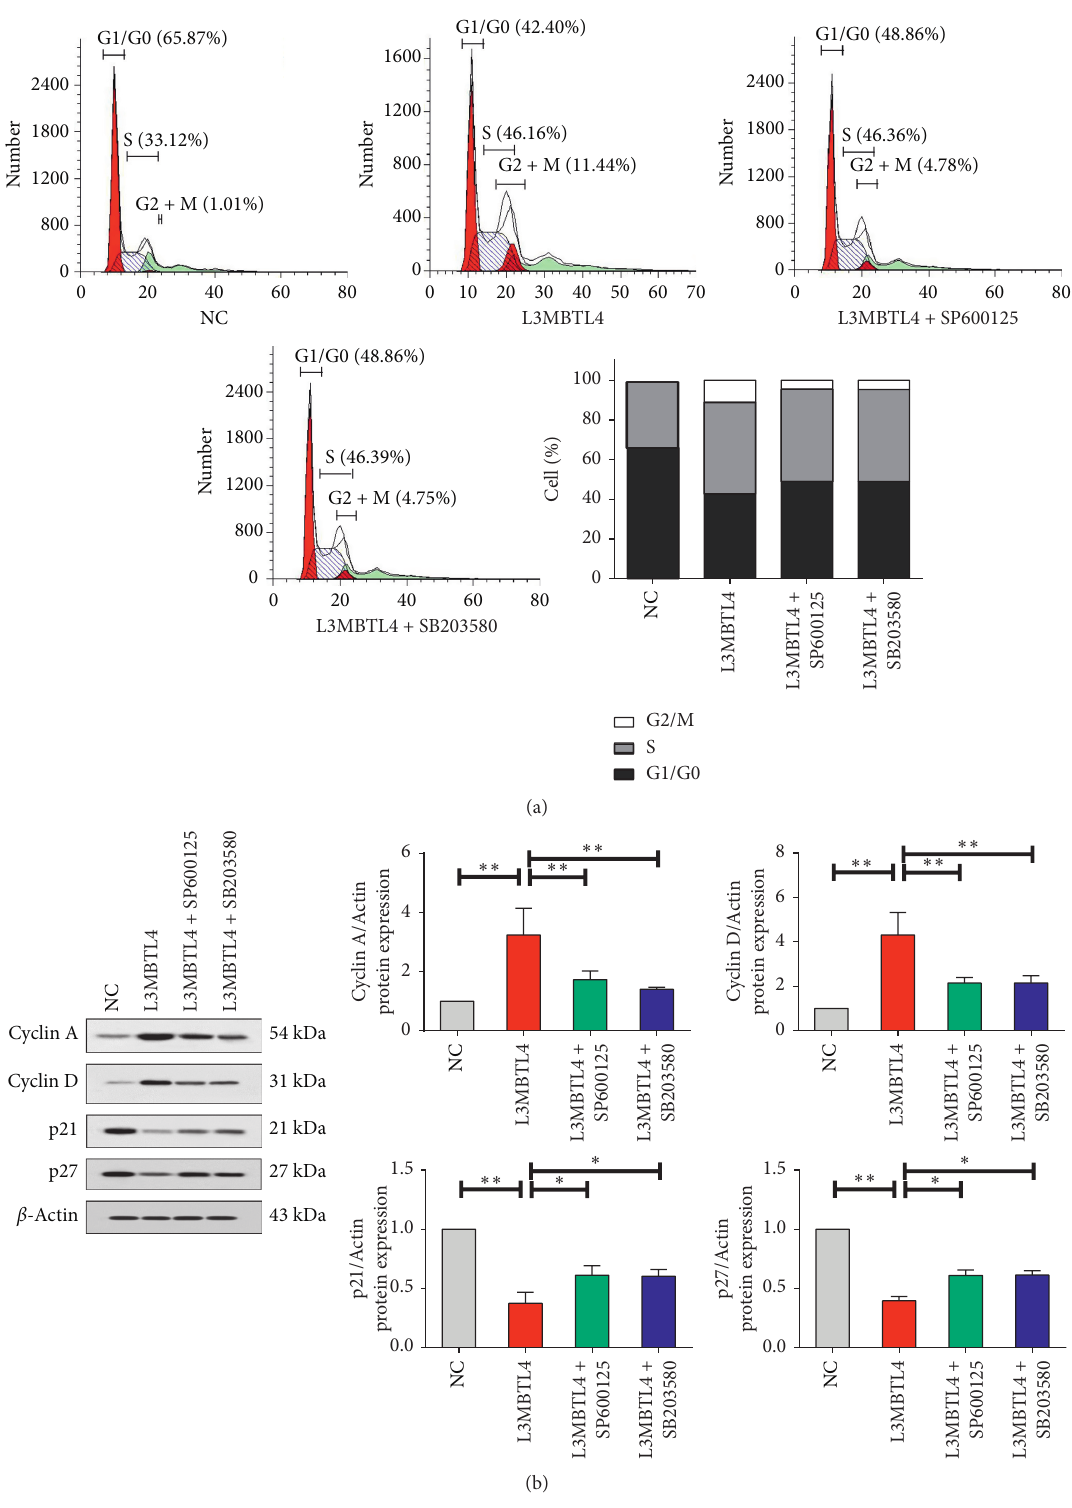
Figure 4: p38/JNK was required for propelled cell cycle mediated by L3MBTL4 . (a) The percentage of cells in G0/ G 1, S , and G2/M phases of cell cycle in NC, L3MBTL4 overexpression VSMCs, L3MBTL4 overexpression VSMCs+ SP600125, and L3MBTL4 overexpression VSMCs +SB2003580 was quantified by flow cytometer analysis ( n � 3). (b) Western blot analysis of cyclin A , cyclin D , p21, and p27 expression ( n � 3). ∗ p < 0 . 05; ∗∗ p < 0 . 01; ∗∗∗ p < 0 .